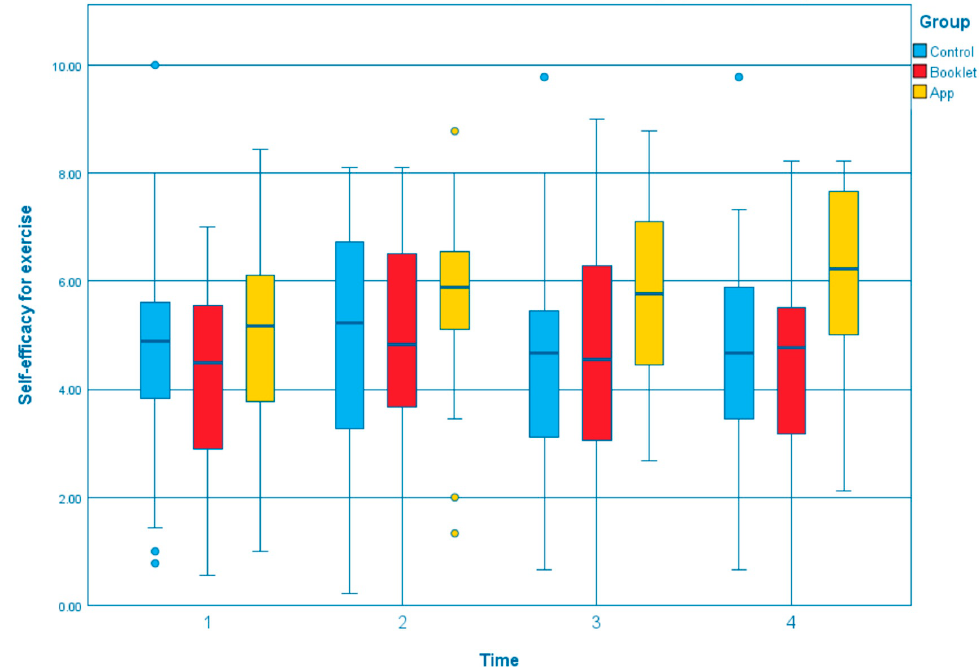
Figure 4. Boxplot of the change of self-efficacy for exercise at different time point among the groups. Table 2. Comparing the effects of the app and booklet group at week 24.